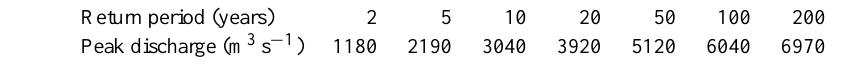
Table 1. Peak Discharge of floods with different return periods calculated from measurements at the Beichuan Hydraulic Station.